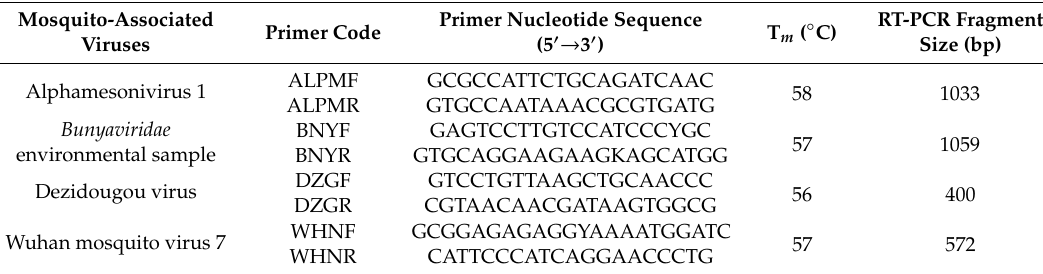
Table 1. Virus-Specific Primers for